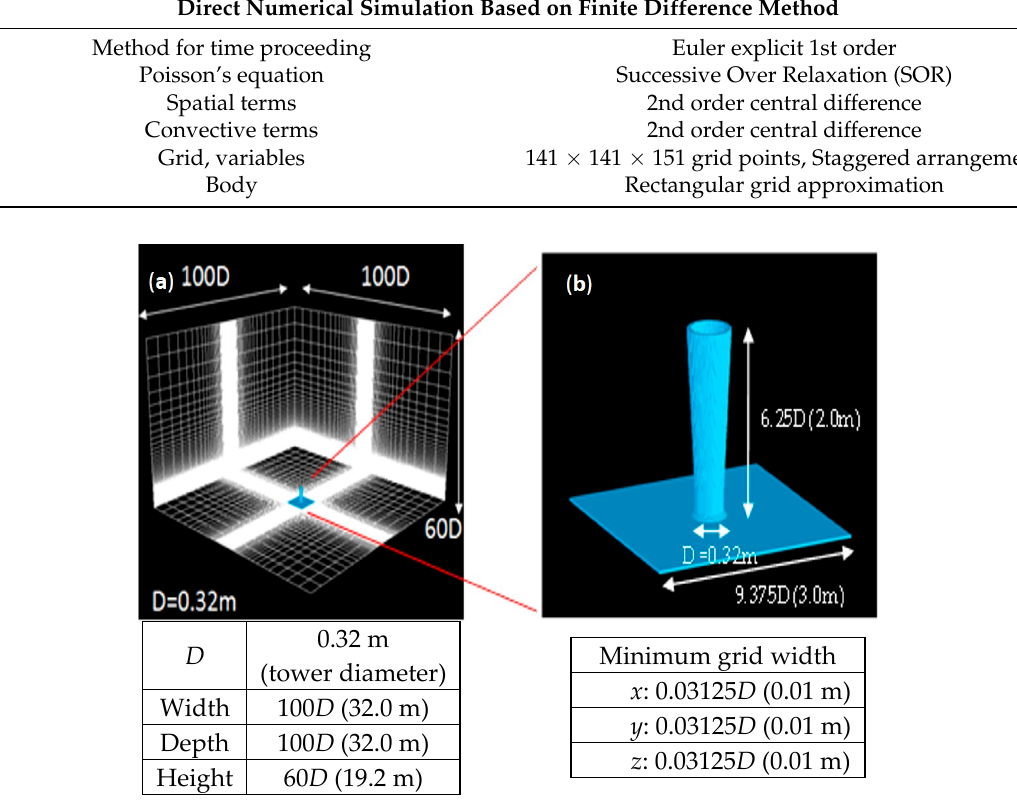
Figure 11. ( a ) Computational domain and grid; ( b ) A diffuser tower model with 4° semi-open angle was displayed using a rectangular grid approximation technique.